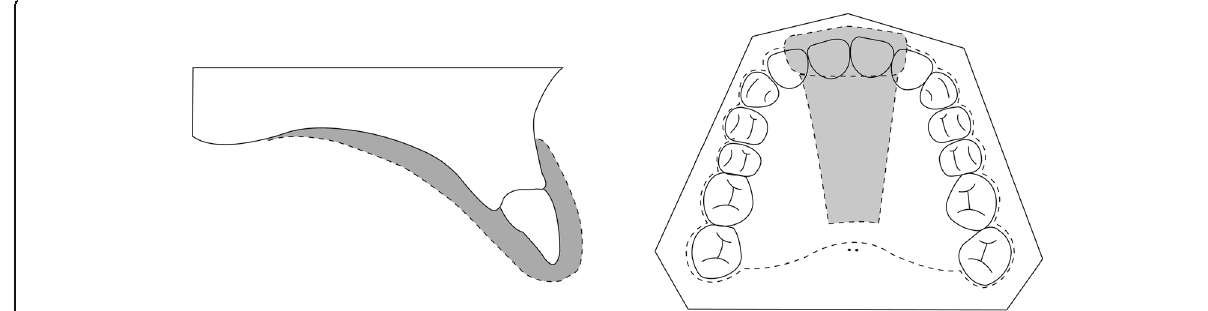
Fig. 2 Schematic illustration of a customized clear BIOSTAR plate. The plate has space around the central incisors and along the middle of the hard palate. The dotted line represents the boundary of the retainer. The gray-colored area represents the space filled with contrast medium gel